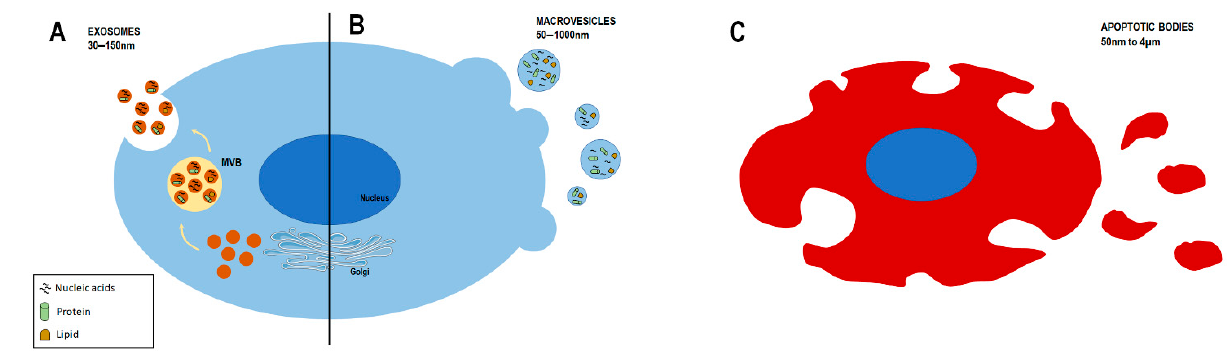
Figure 3. A representative scheme reporting the principal classes of extracellular vesicles (EVs) of eukaryotic cells. EVs can be divided into exosomes ( A ), macrovescicles ( B ), and apoptotic bodies ( C ), which vary according biogenetic mechanism, size, and other characteristics. MVB: multivesicular